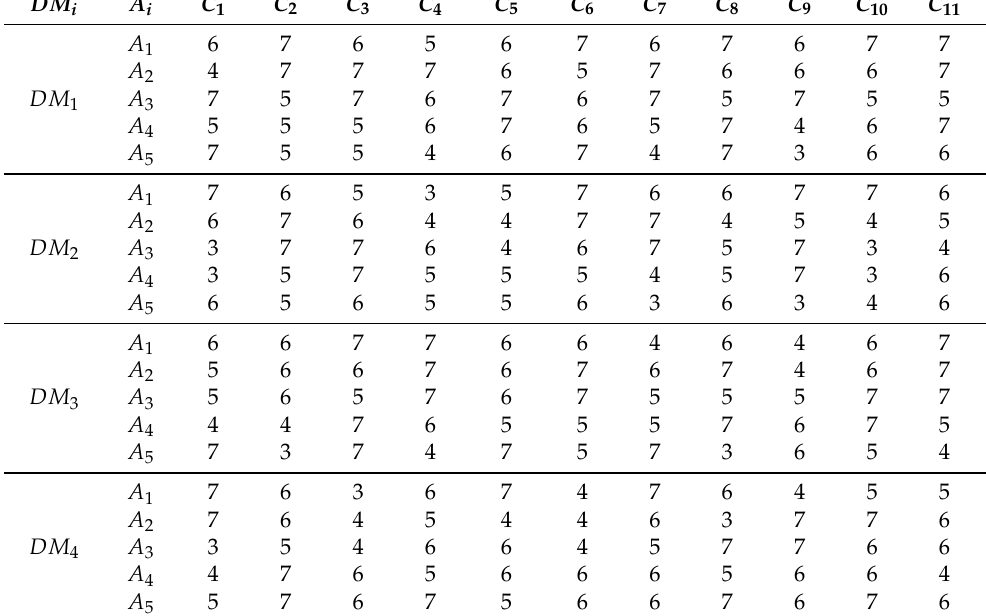
Table 3. Linguistic evaluation for rating of the alternatives by decision makers. DM i